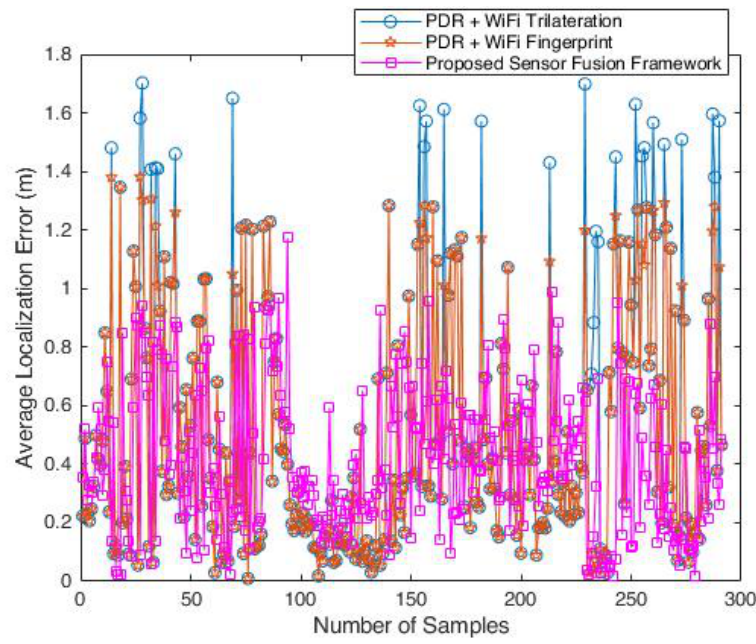
Figure 9. Average localization error from rectangular motion.